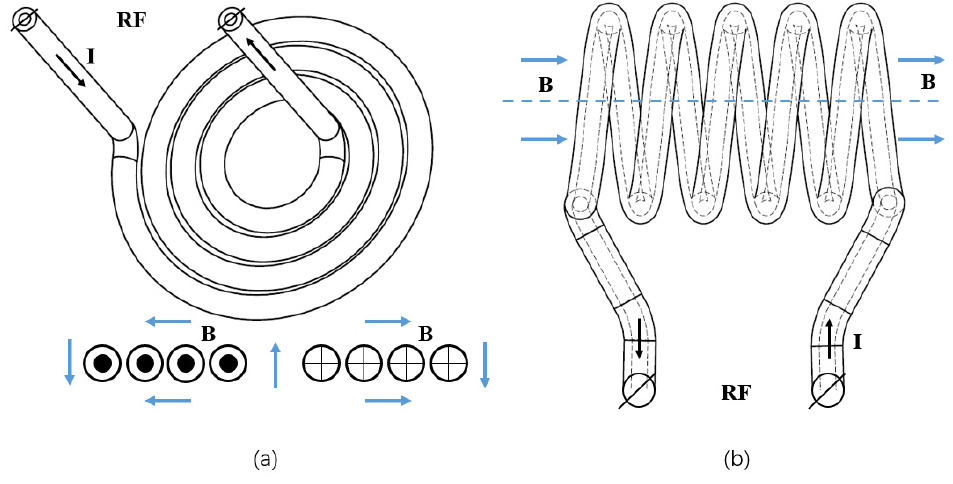
Figure 1. Two RF antenna patterns used for ICP: ( a ) planar antenna ( b ) cylindrical antenna.